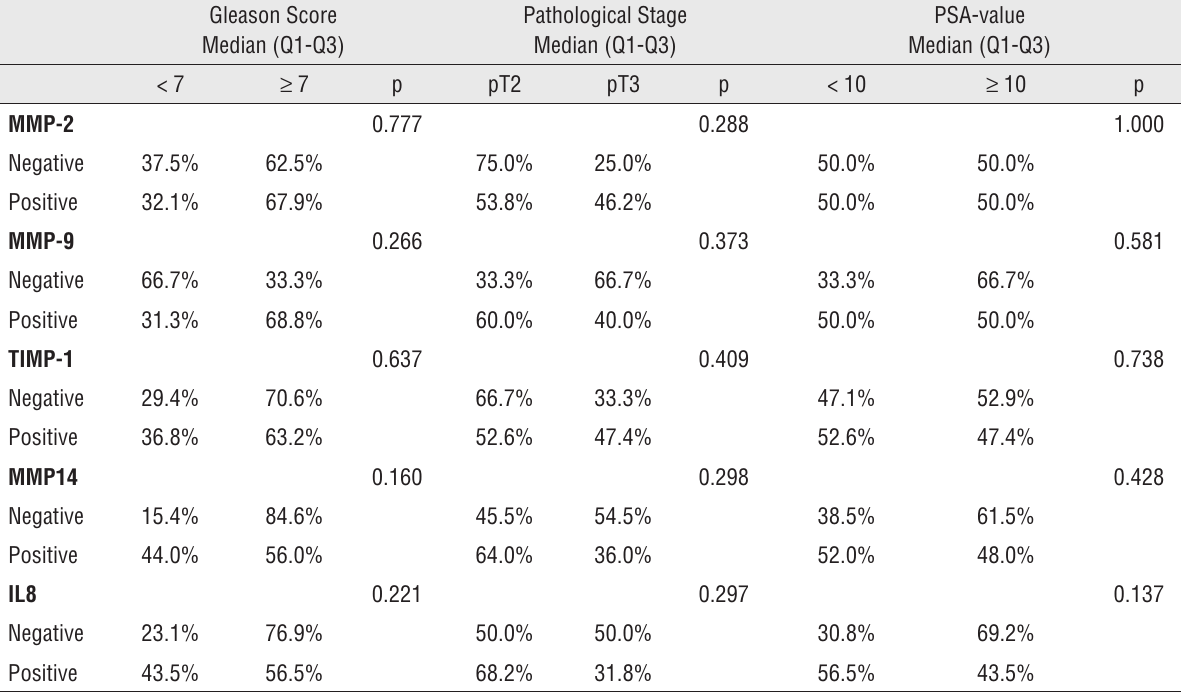
Table 3 - protein expression and gleason score, pathological stage and psA-value.